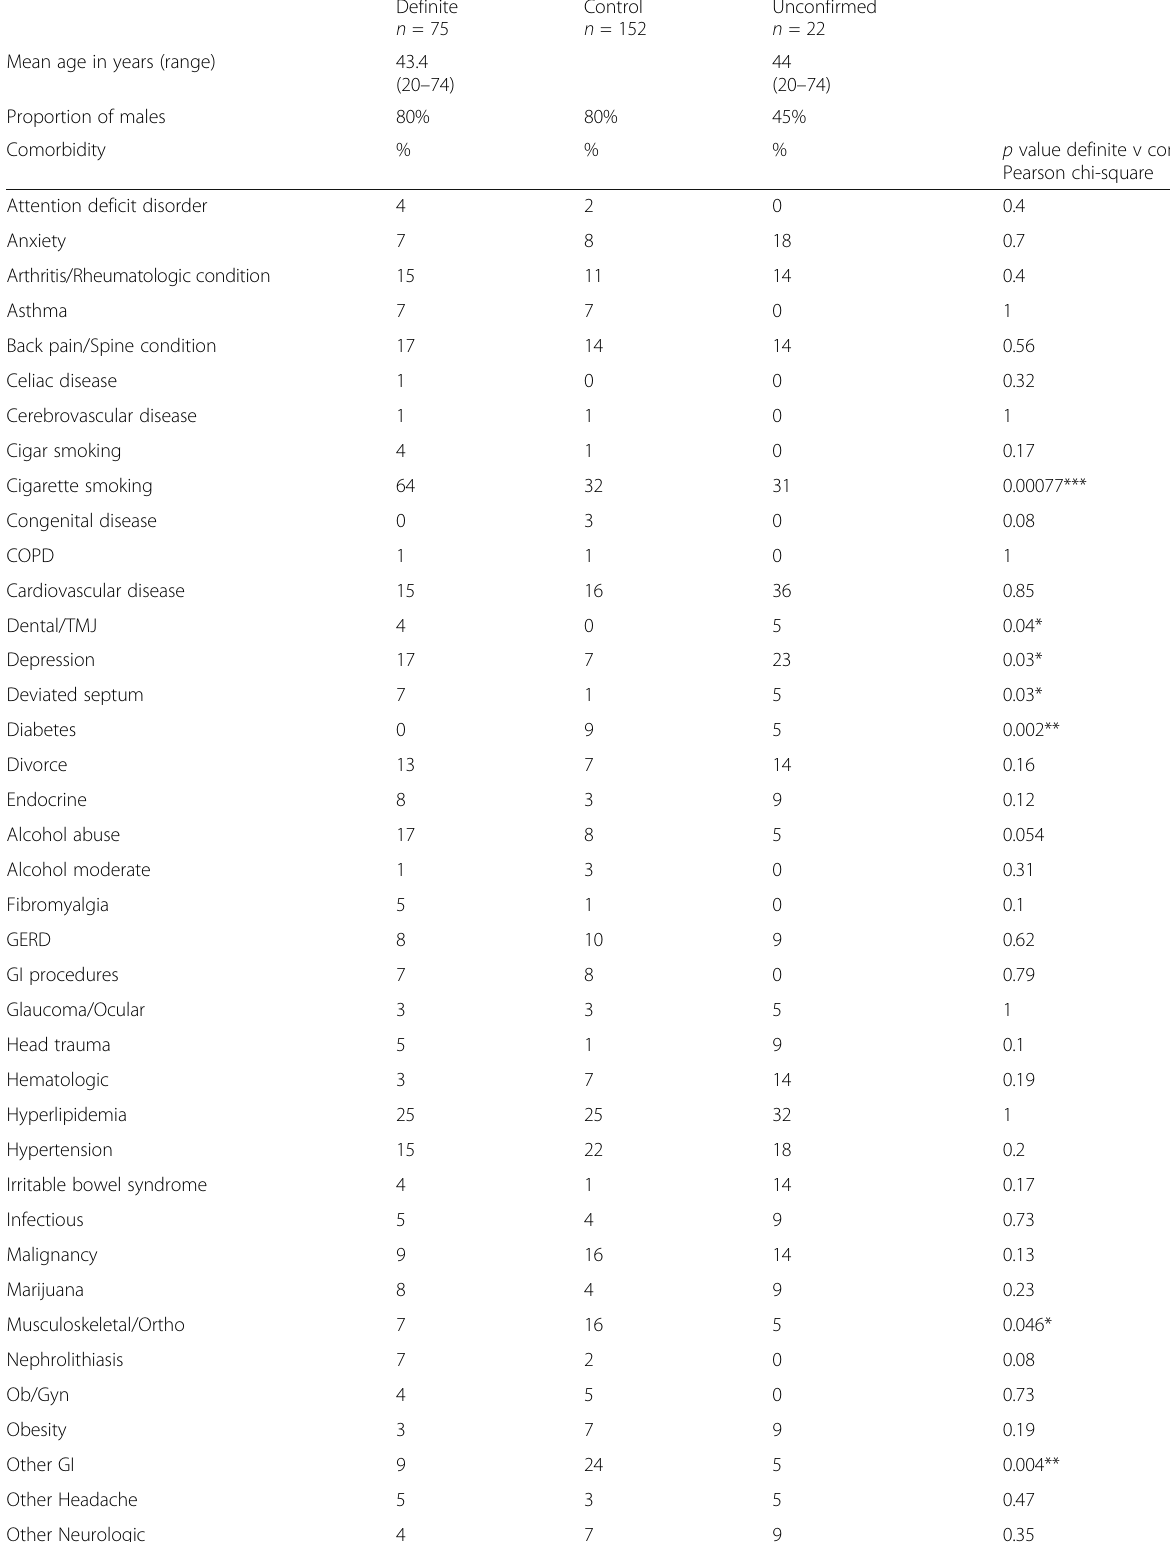
Table 2 Demographic characteristics and prevalence of comorbid conditions in patients with definite and unconfirmed CH and